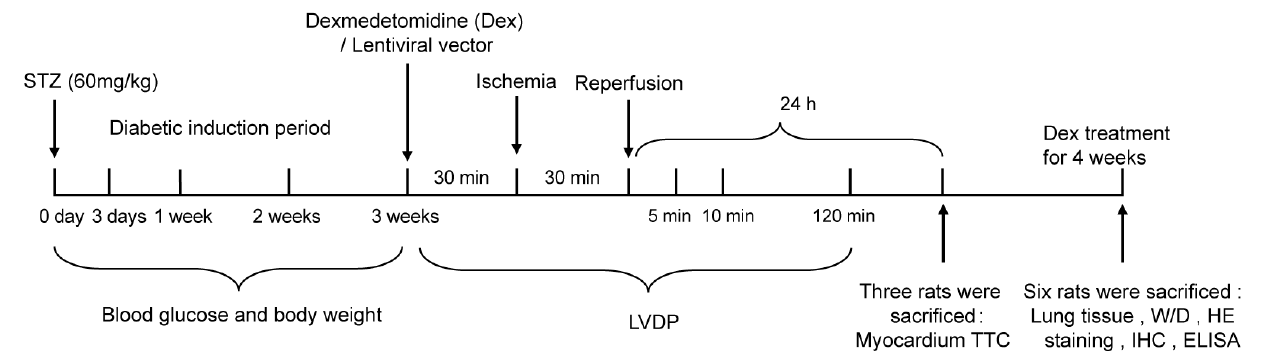
Fig. 1 - Timeline of the treatment of the studied rats. The figure shows the diabetes induction period, ischemia/reperfusion period, Dex administration time points, animal sacrifice time points, and test indicators of each time point. ELISA=enzyme-linked immunosorbent assay; HE=hematoxylin and eosin; IHC=immunohistochemistry; LVDP=left ventricular developed pressure; STZ=streptozocin; TTC=2, 3, 5-triphenyltetrazolium chloride; W/D=wet/dry